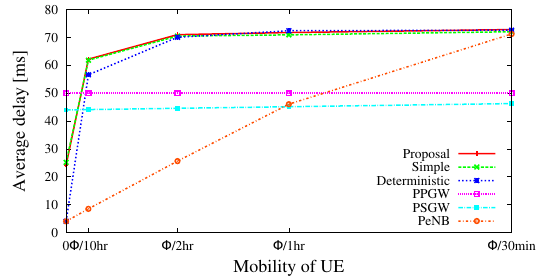
Figure 6: Fairness in Scenario 1 ( ρ = 1 )